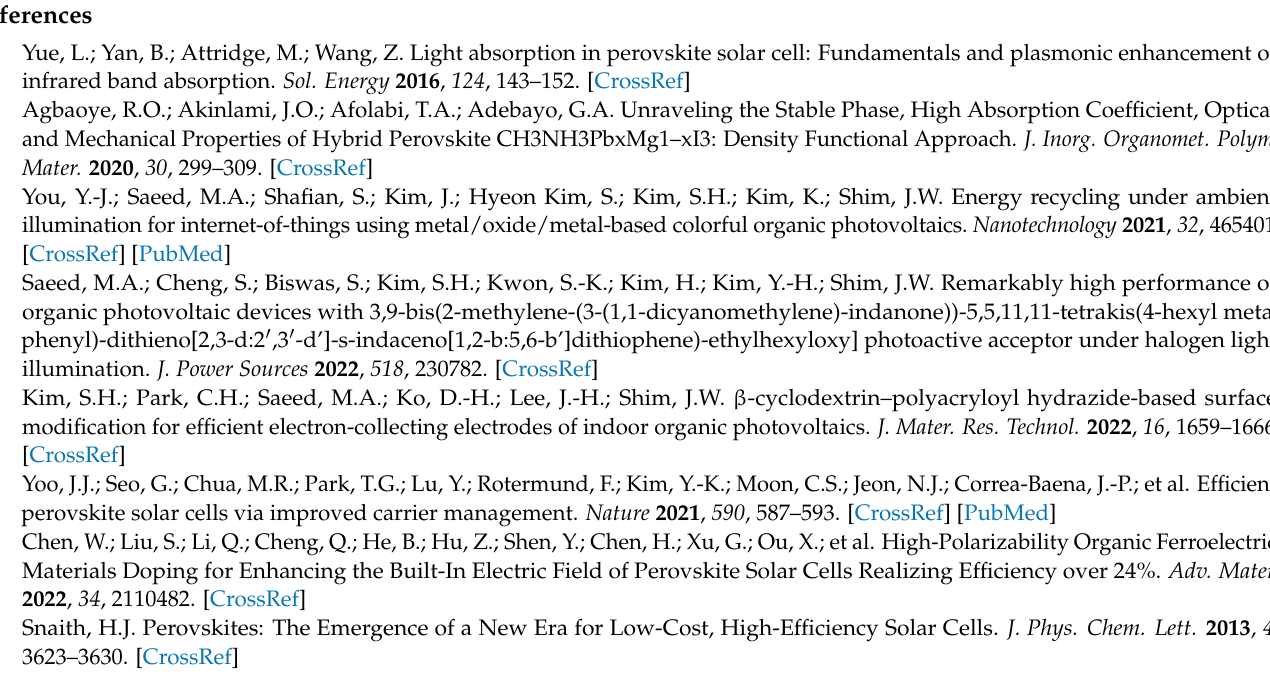
Figure S2: The grain size of perovskite films without and with different Tween 20 concentrations; Figure S3: FE-SEM images of cross-section PSC (a) without and with 1.0 mM Tween 20; Figure S4: The grain size of perovskite films with 1.0 mM Tween 20 with different fabrication temperatures; Figure S5: The top-view surface morphologies of perovskite film with 1.0 mM Tween 20 under two different preparation methods, including (a) spin coating and (b) thermal assisted blade coating method; Table S1: The morphological characteristics (Ra and RMS) of perovskite films with various Tween 20 concentrations by using AFM